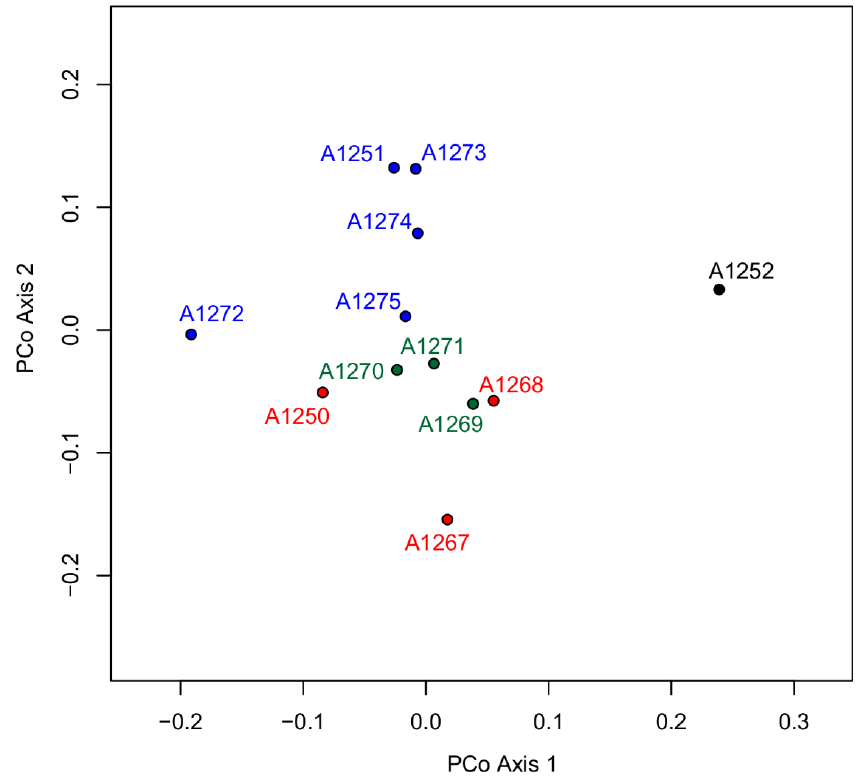
Figure 6. Ordination of accessions of A. fucensis (black) and A. volgensis (blue: Romania; red: Russia; green: Kazakhstan) based on pairwise Nei distances from 2944 single-nucleotide polymorphisms (SNPs) from 486 AFLPseq loci in a Principal Co-ordinate Analysis (PCoA), with axis 1 explaining 20.8% and axis 2 explaining 15.0% of the total variance, respectively.